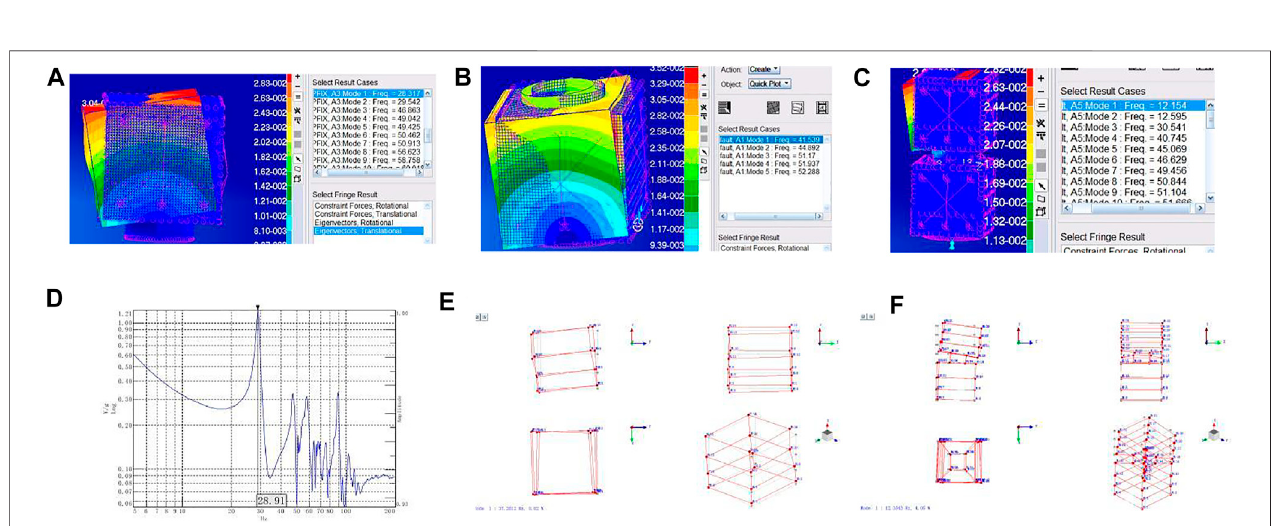
FIGURE6| Themodalanalysisandexperimentalresultsofaself-tandemdualsatellite. (A) Theuppersatellitemodalanalysis(the fi rst-order28.3Hz). (B) Thelower satellite modal analysis (the fi rst-order 41.5Hz). (C) The modal analysis of combination (the fi rst-order 12.2Hz). (D) The results of the upper satellite frequency sweep mode test (the fi rst-order 28.9Hz). (E) The lower satellite mode test results (the fi rst-order 37.3Hz). (F) The combination modal test results (the fi rst-order 12.4Hz).